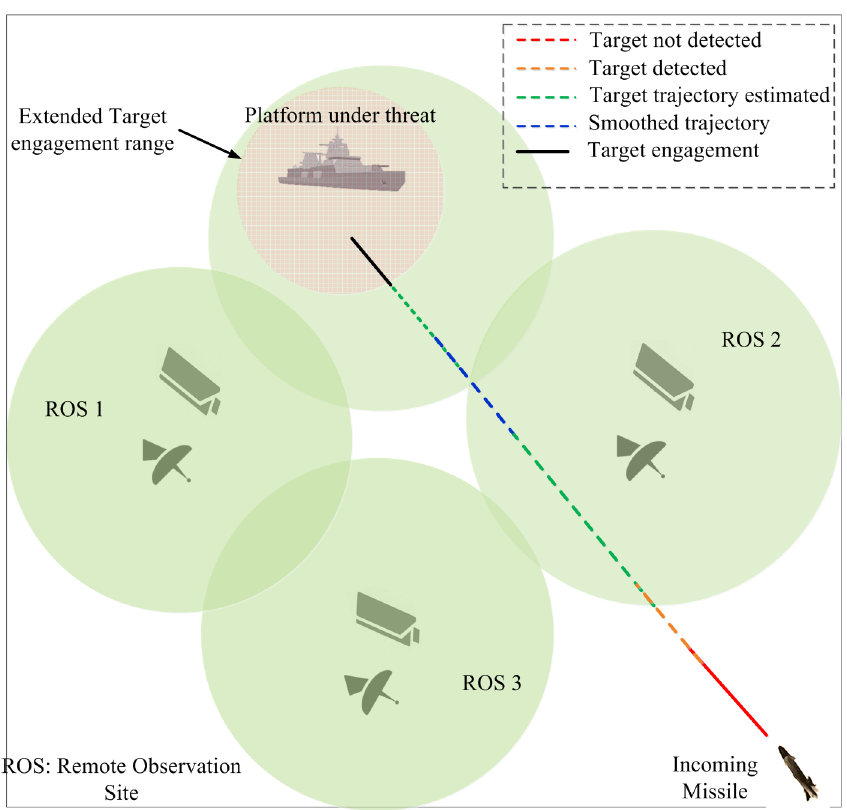
Figure 2. Working of the proposed system with multiple Remote Observation Sites (ROSs) and the targeted